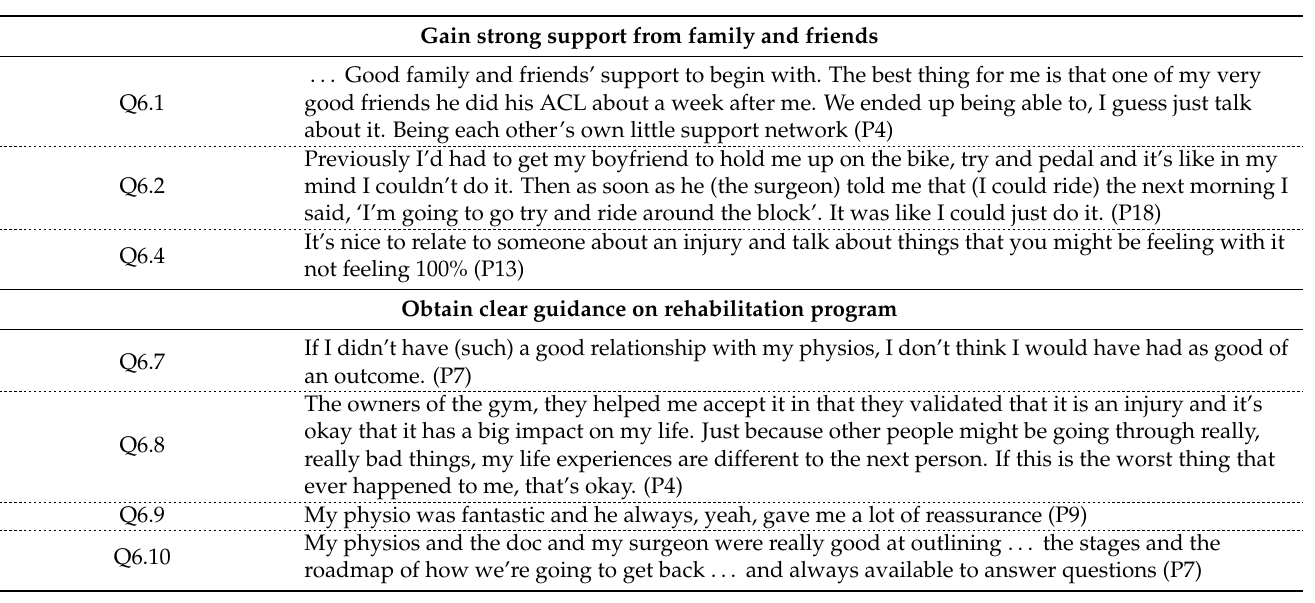
Table 7. Supporting Quotes: Theme 6—Positive coping strategies reducing